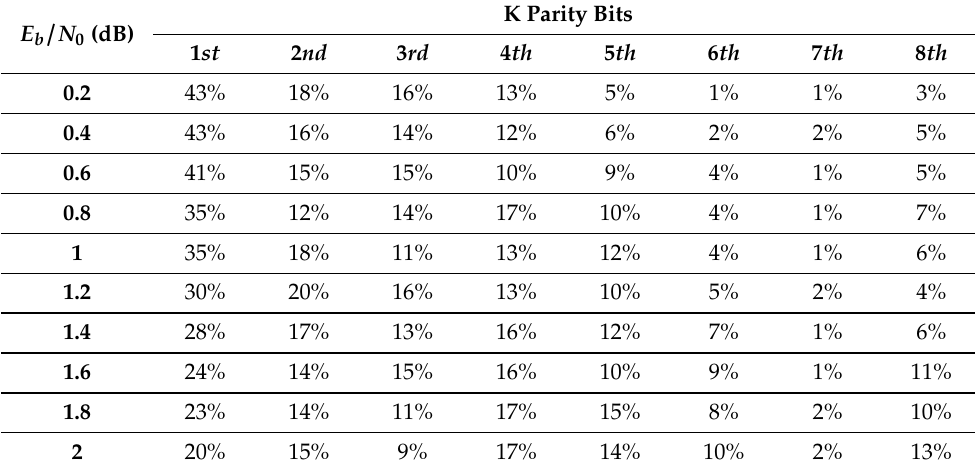
Table 1. Summary of event γ the PC-CRC-SSCFlip decoder with N = 512, K = 256, T = 10, α = 1 and K = 8 for 10 7